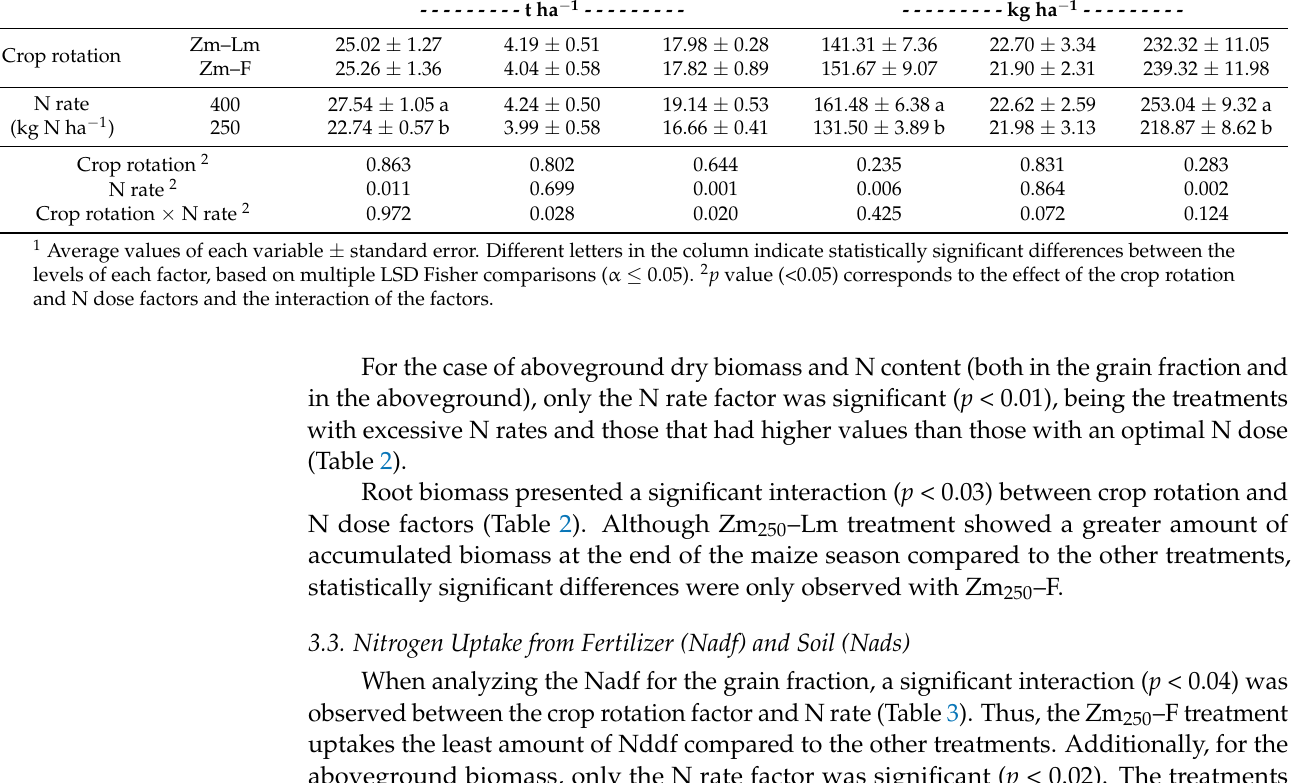
Table 2. Grain yield, biomass, and nitrogen (N) content in the aboveground biomass, root, and grain of the maize crop.